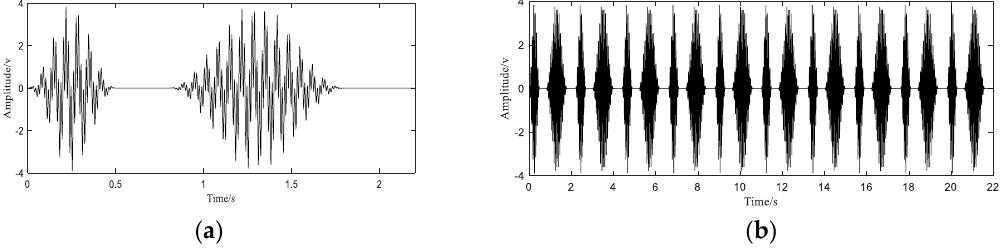
Figure 3. A full-cycle simulation signal ( a ) and simulation signal after extension ( b ).